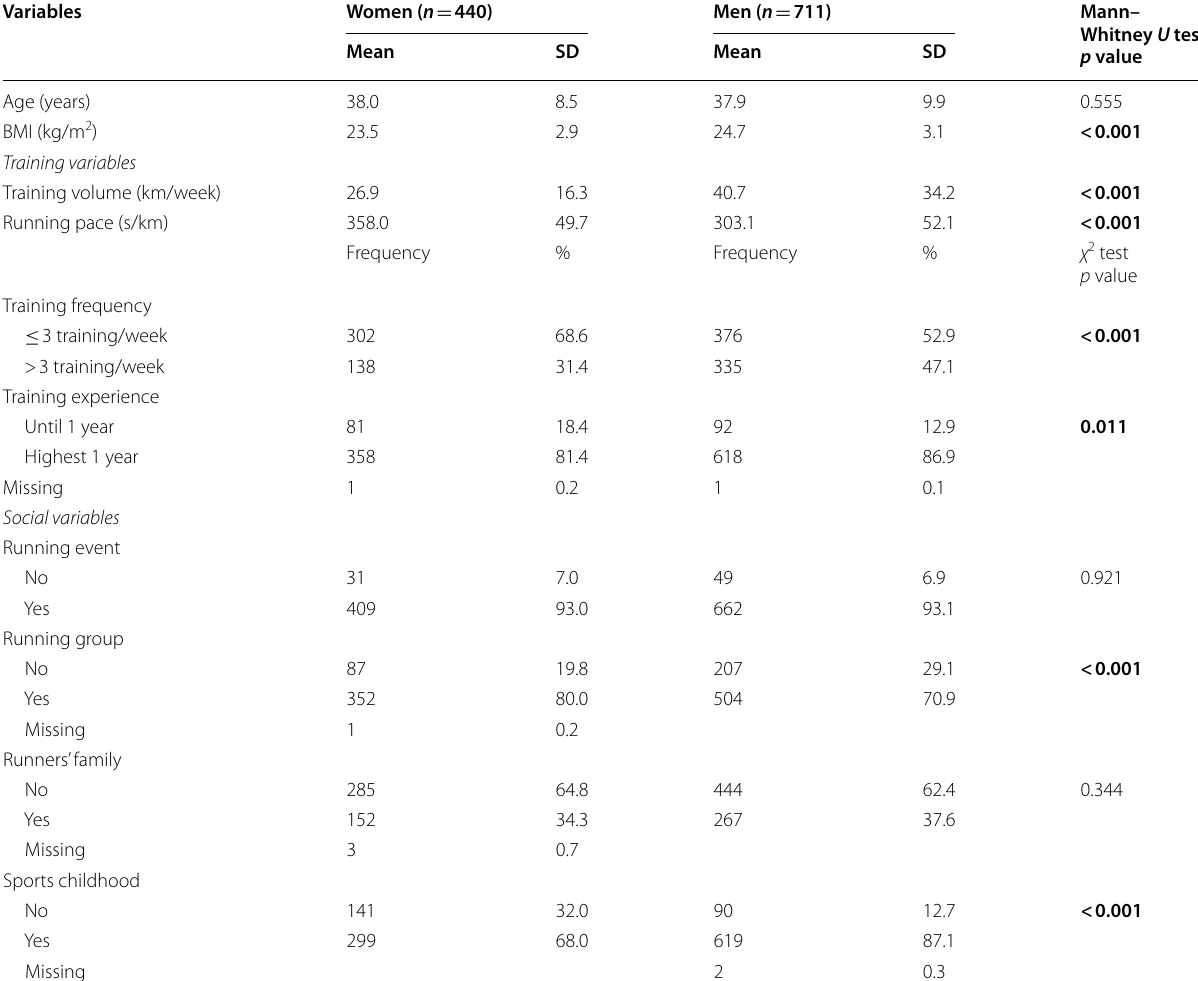
SD or frequency (%)] and comparisons, considering both sexes ±